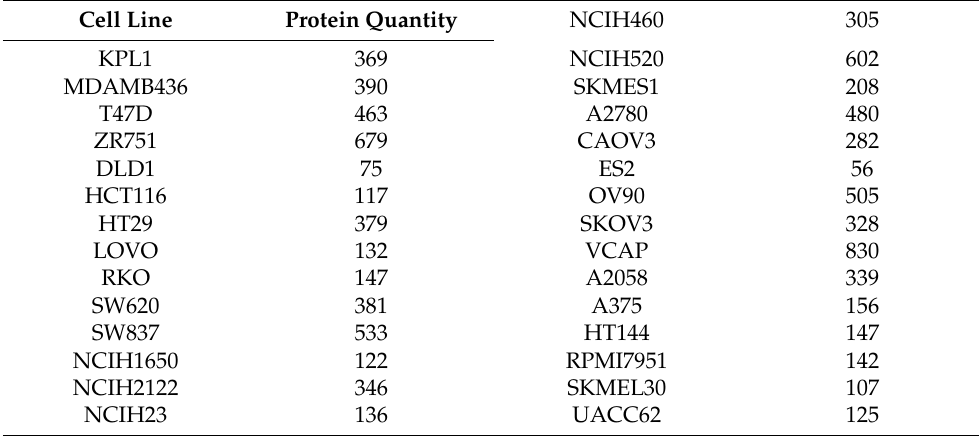
Table 4. The number of target proteins associated with each cancer cell.